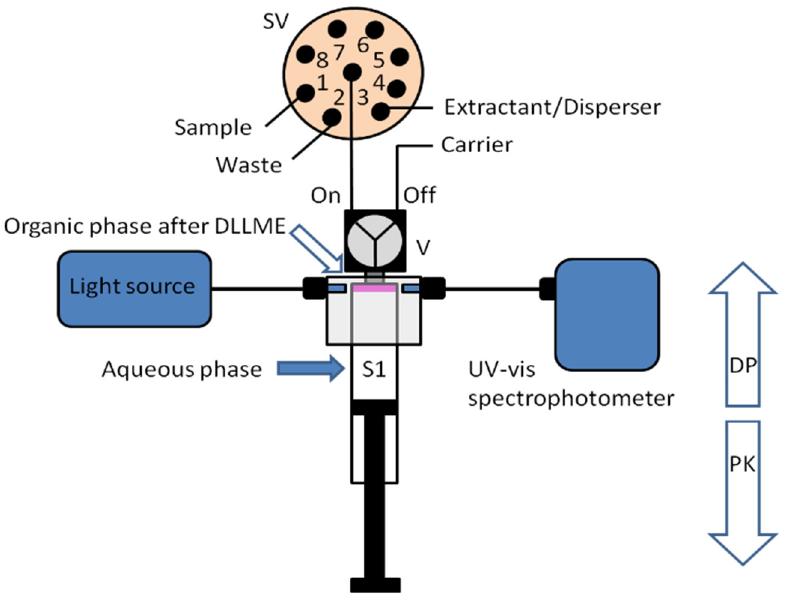
Figure 3. Schematic representation of the developed system for in-syringe DLLME with integrated spectrophotometric detection [18].